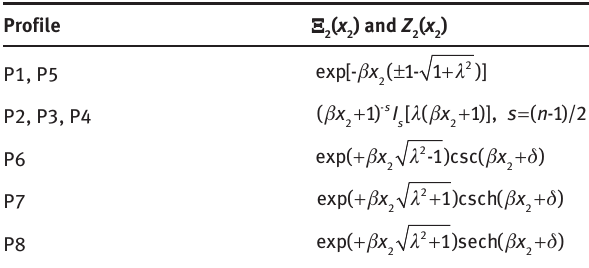
( x ) for the special inhomogeneity 2 2